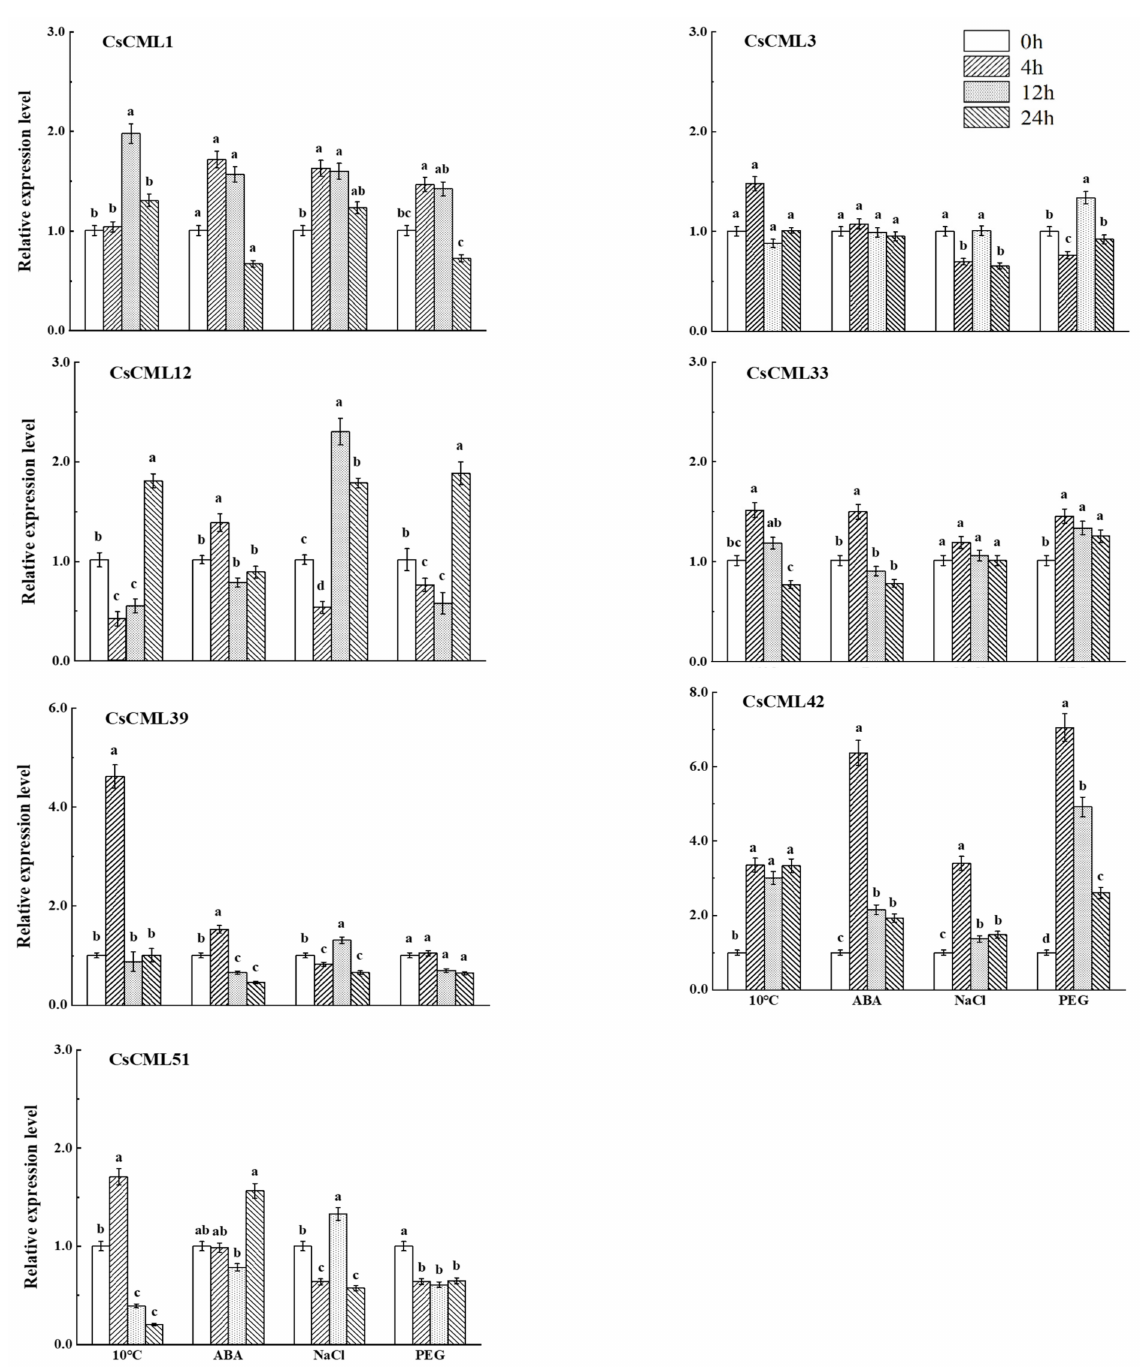
Figure 9. Response of seven CsCML genes to abiotic stress in tea leaves. The untreated plants were treated with low temperature (10 ◦ C), drought (20% PEG 6000), high salt (200 mmol/L NaCl) and ABA (100 µ mol/L). Samples were taken at 0, 4, 12, and 24 h after stress treatment. Three biological replicates were set at each time. Gene expression was detected using qRT-PCR. Different lowercase letters indicate significant differences between different time periods under the same treatment ( p <